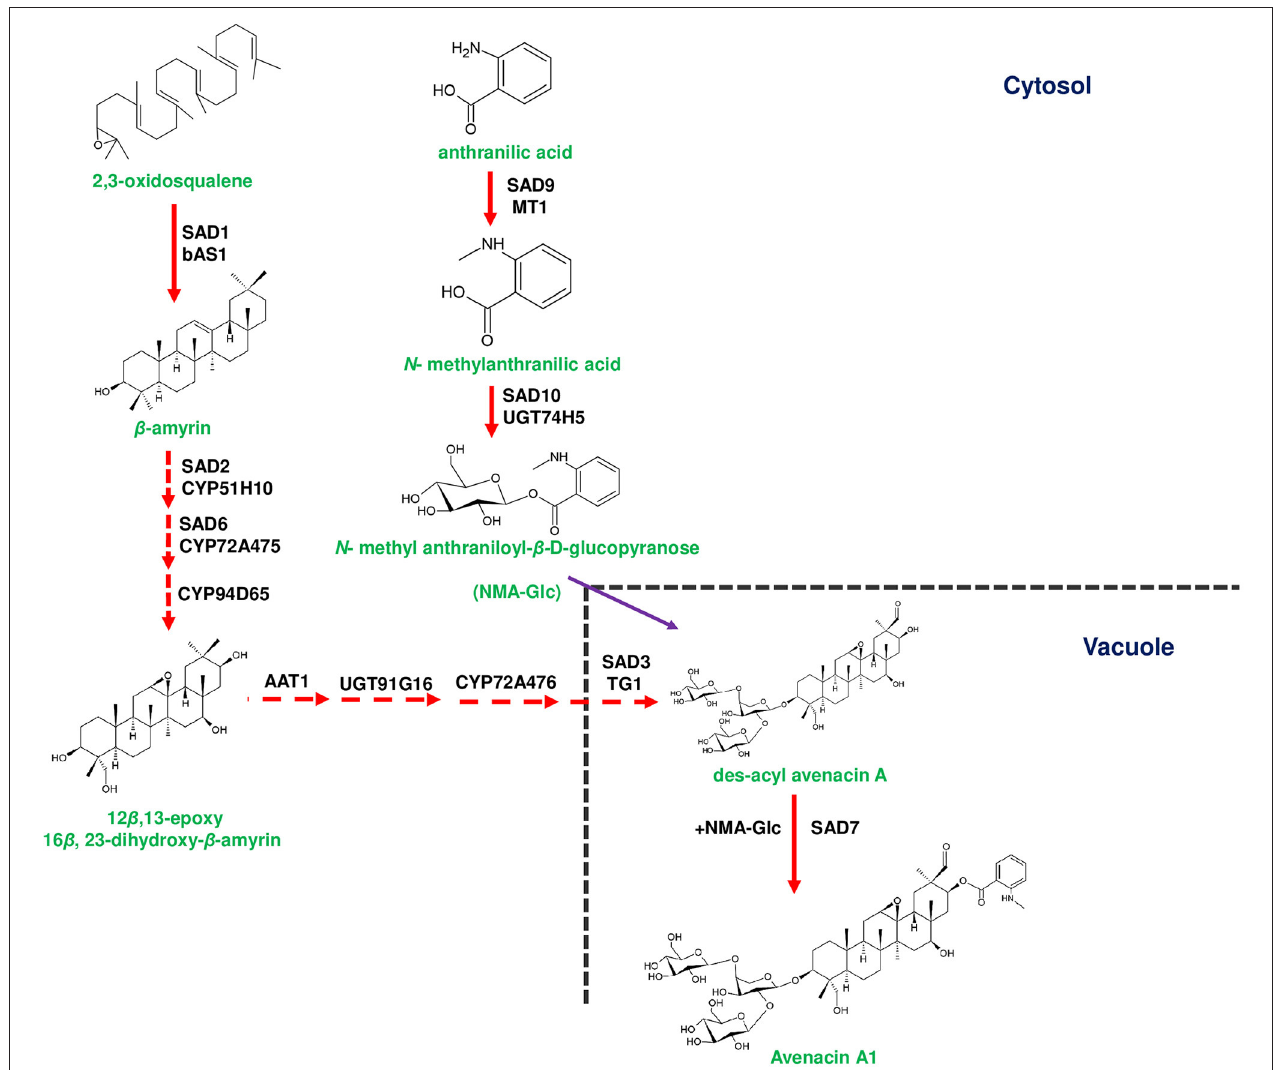
FIGURE 1 | Biosynthetic pathway of avenacin in the roots of Avena strigosa . Avenacin biosynthesis starts with the conversion of 2,3-oxidosqaulene to β -amyrin by Sad1 (Saponin deficient 1). Conversion of β -amyrin to 12 β ,13-epoxy 16 β , 23-dihydroxy- β -amyrin that occurs in the cytosol is mediated by Sad2, Sad6 and CYP94D65, respectively. 12 β ,13-epoxy 16 β , 23-dihydroxy- β -amyrin is subsequently conjugated with one arabinose and two glucose moieties for the formation of des-acyl avenacin. Two glycosylation steps occur in the cytosol catalyzed by A. strigosa arabinosyltransferase ( As AAT1) and As UGT91G16 (UDP-glucosyl transferase). The final glucose moiety is added by a unique vacuolar glycosyltransferase A. strigosa transglucosidase 1 ( As TG1). Des-acyl avenacin is acylated by Sad7 aided by acyl donors such as N -methyl anthranilate glucopyranose (NMA-Glc) to form avenacin A1, in the vacuole. NMA-Glc is formed from anthranilic